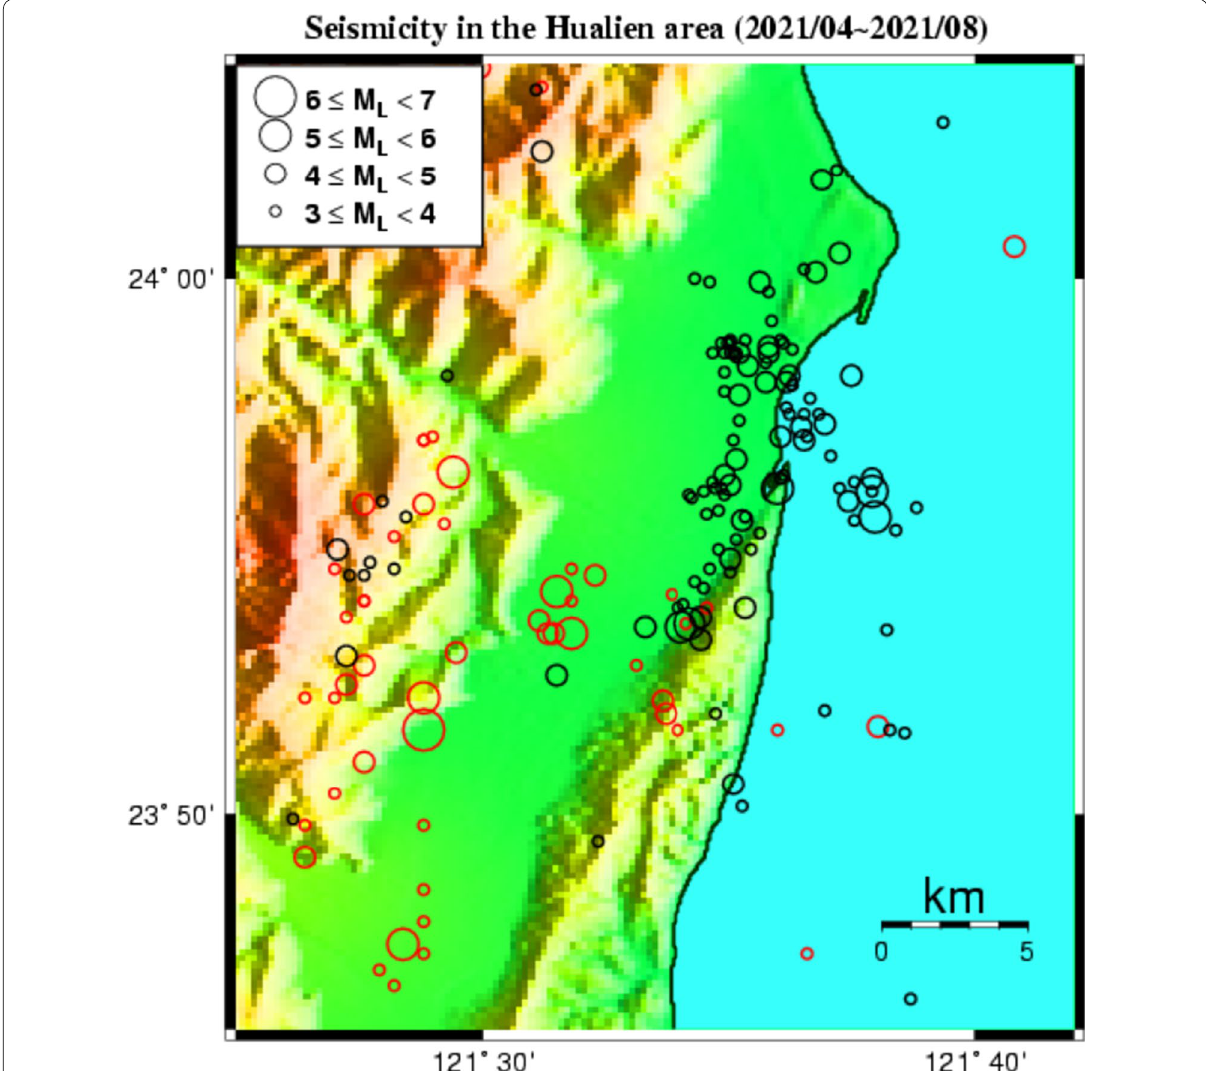
Fig. 2 Epicenters of M L 3 earthquakes from April to June (red circles) and from July to August (black circles). Different sizes of circles show the ≥ magnitudes of